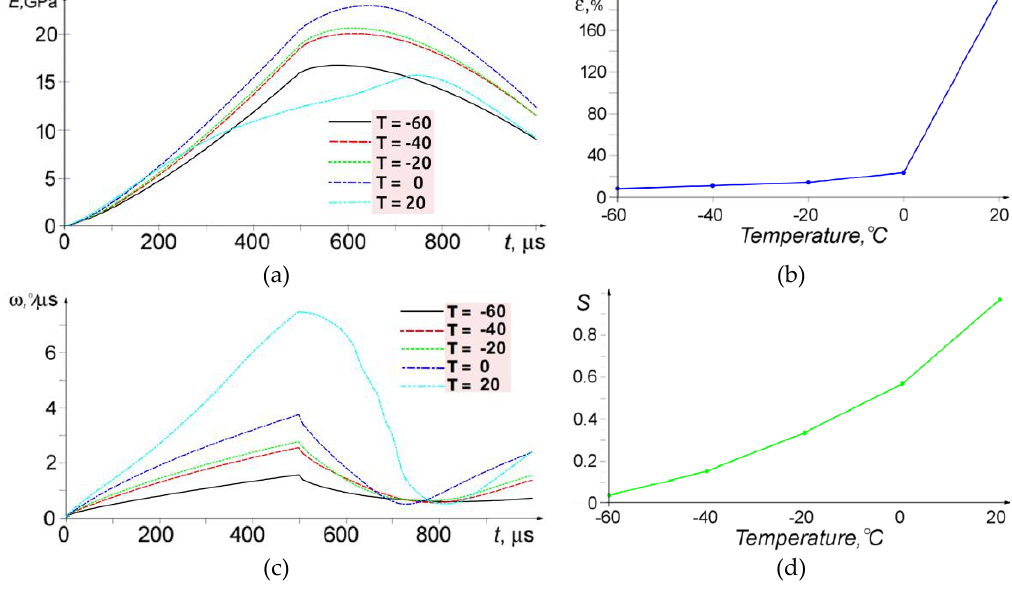
Figure 4. Specific elastic energy of specimens vs. time ( a ); total strain vs. test temperature (500 µm) ( b ); average angular velocity of microrotations vs. time ( c ); and fraction of microrotation energy in the total elastic energy supplied vs. test temperature (500 µm) ( d ). The legends show the temperatures T in °C.